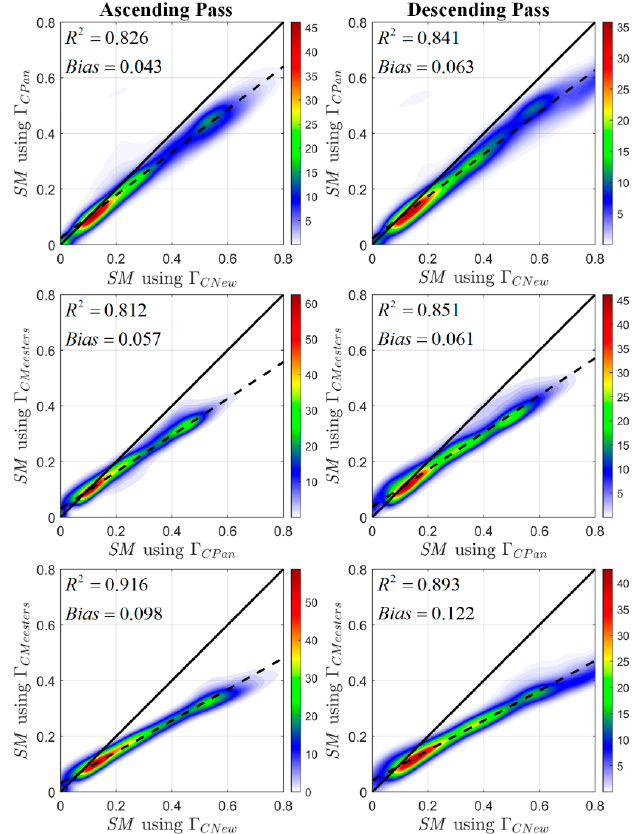
Figure 2. Scatter density plots of mean advanced microwave scanning radiometer (AMSR)-E SM of the retrievals obtained by employing three analytical solutions in the RTM framework. Retrievals corresponding to ascending and descending passes are plotted in the first and second columns of the figure, respectively. The thick and the dotted lines in each plot represent the normal line (45 ◦ line) and best fit line,